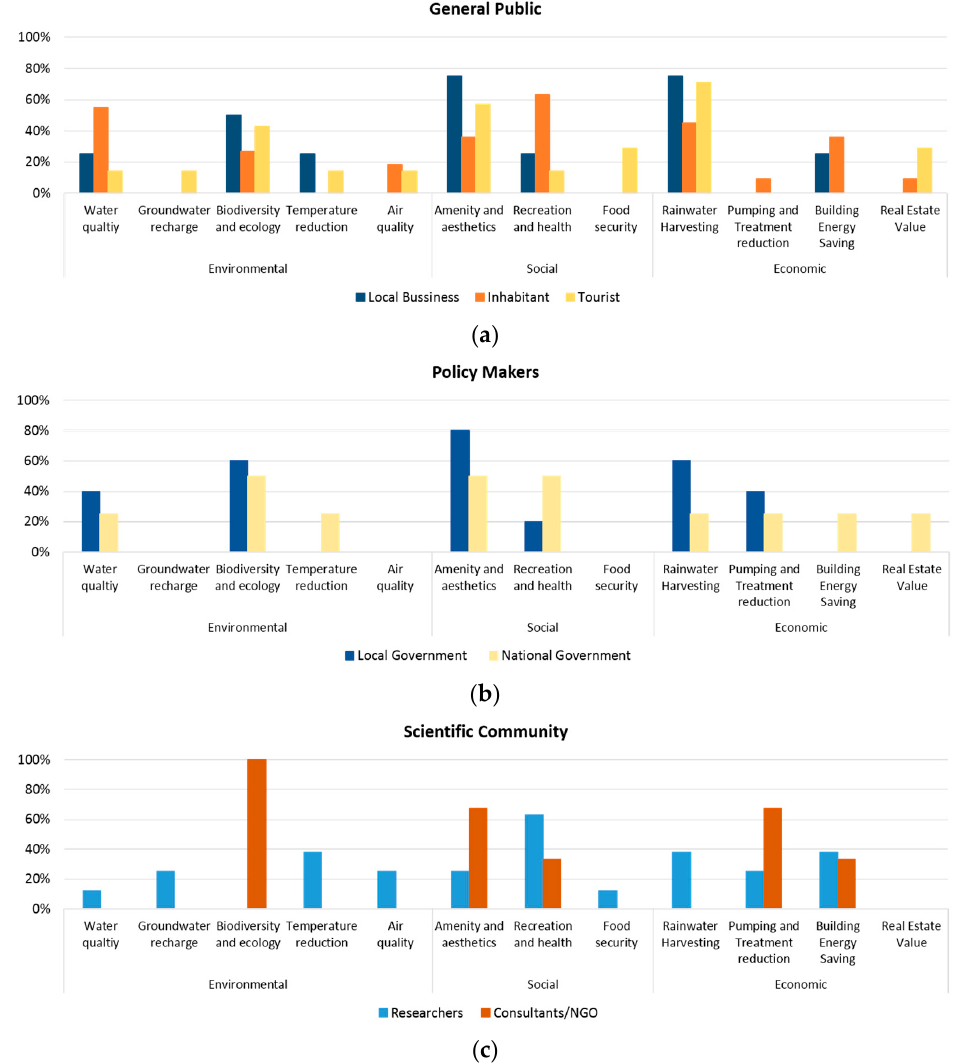
Figure 8. Answers to the questionnaire by different stakeholders’ types: ( a ) general public: local business owners, inhabitants, and tourists; ( b ) policy makers: people form local and national government; ( c ) scientific community: researches and consultants, and NGO people.